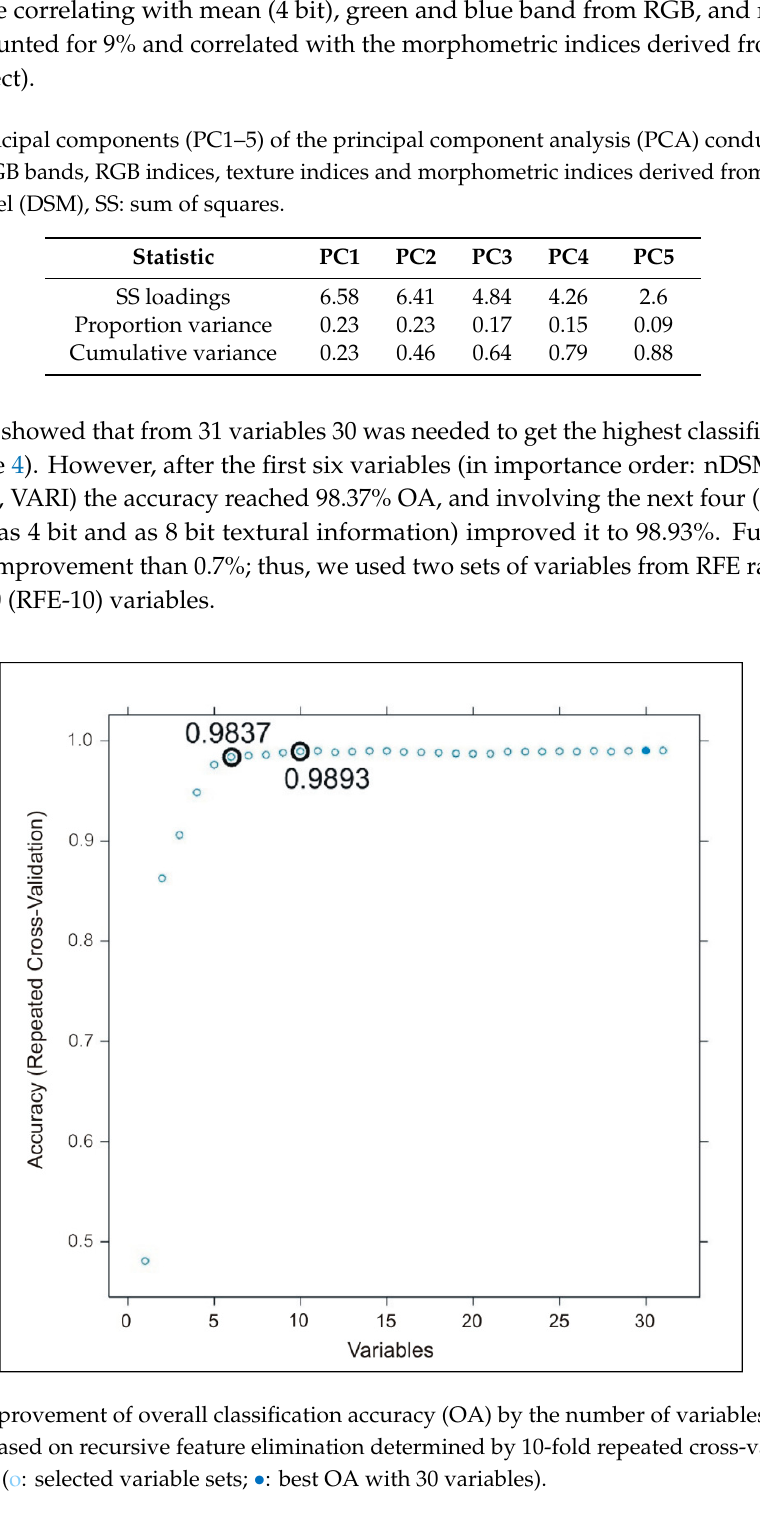
di ff erence entropy, energy, entropy, grey-level non-uniformity, inertia, variance. PC2 accounted also for 23% variance and correlated mainly with the same textural indices in 8 bit form. PC3 accounted for 17% variance correlating with the RGB indices and some of textural indices: normalized green-red di ff erence (NGRDI), red-green-blue vegetation index (RGBVI), green leaf index (GLI), red band from